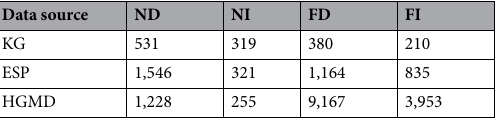
Table 1. Summary about data used in the simulation studies. Abbreviations: ND (nonframeshift deletion), NI (nonframeshift insertion), FD (frameshift deletion), FI (frameshift insertion). Each entry denotes the number of indels for each indel subtype in the three datasets.